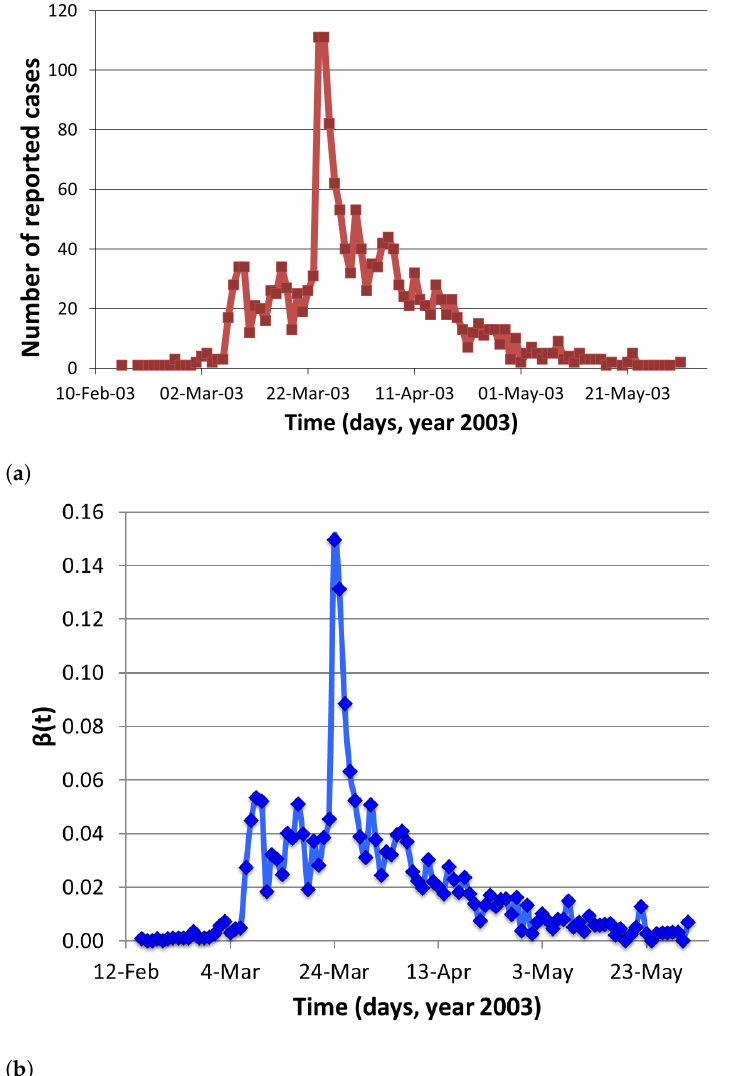
Figure 7. The 2002–2003 SARS outbreak in Hong Kong: ( a ) Daily reported cases; ( b ) Estimation of β ( t ) using available incidence data. Prevalence for 16 April 2003 was taken in the calculation when number of symptomatic cases started declining